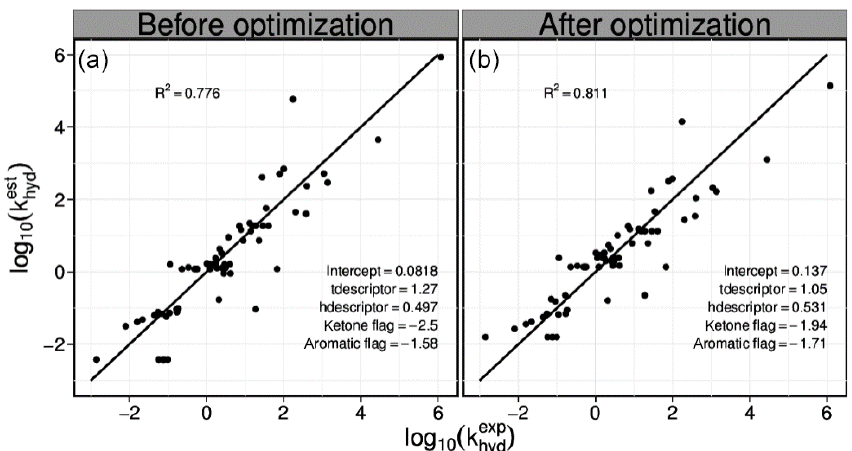
Figure 1. Scatterplots of the estimated log( K hyd ) using the SAR from Raventos-Duran et al. (2010) versus the experimental log( K hyd ) , before (a) and after (b) the optimization for carboxylates. Values for the optimized descriptors are shown on the bottom right of each panel. The values chosen before the optimization are taken from Raventos-Duran et al. (2010). The line is the y = x line.